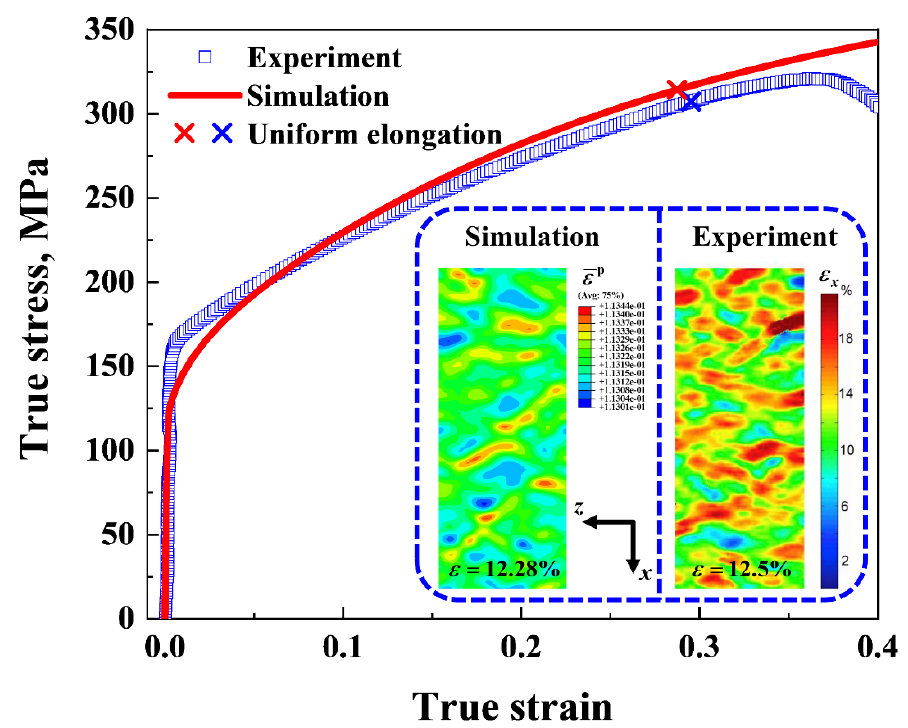
Figure 12. Comparison of the engineering stress-strain curve between the 3D simulation and the experimental data [36]. The strain distribution at the top surface (in the xz -plane) of the sample under the applied strain of ~12.5% in both the simulation and the experiment are presented in the inset. The experimental strain map was reprinted from [36] with permission from Elsevier.